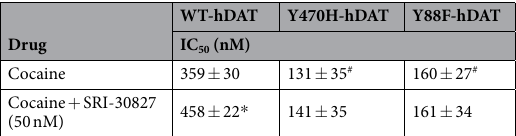
(50 nM) following addition of cocaine (1 µ M) significantly increased the cocaine IC 50 value to 458 ± 22 nM, t (9) = 2.60, p < 0.05) in WT-hDAT. However, the allosteric modulatory effect of SRI-30827 on cocaine-mediated